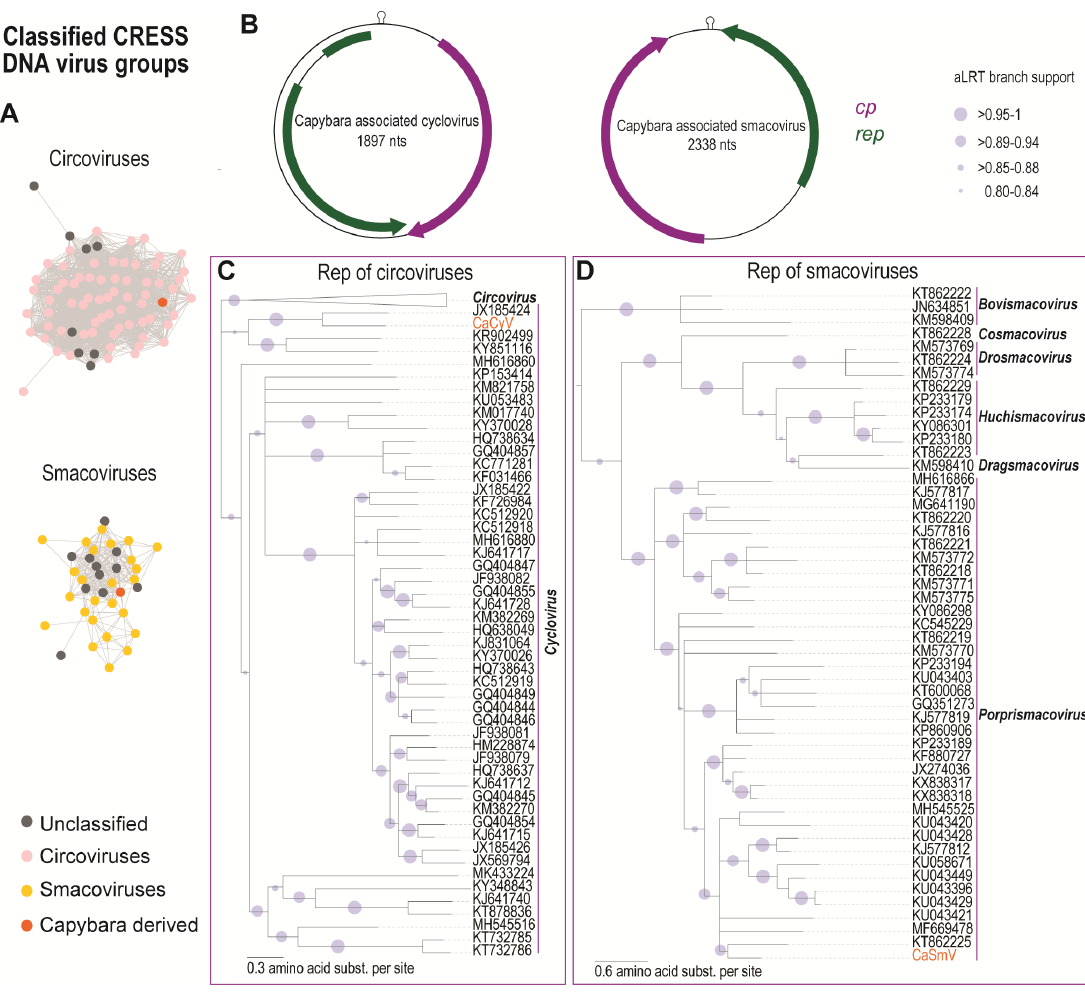
Figure 3. ( A ) Sequence similarity network analysis of the Rep amino acid sequences of viruses in the families Circoviridae and Smacoviridae . Orange dots represent the Rep of the viruses identified in this study. ( B ) Genome organisation of the capybara associated cyclovirus and capybara associated smacovirus. ( C ) Maximum Likelihood (ML) phylogenetic tree of the Rep amino acid sequences of the capybara associated cyclovirus with representative Rep sequences from viruses in the family Circoviridae . The cyclovirus Rep ML phylogenetic tree is rooted with representative sequences of unclassified CRESS DNA group (Cluster 1; Figure 4) and branches with aLRT support < 0.8 have been collapsed. ( D ) ML phylogenetic tree of the Rep amino acid sequences of the capybara associated smacovirus with representative Rep sequences from viruses in the family Smacoviridae . The ML tree has been rooted with Reps of nanoviruses, and branches with aLRT support < 0.8 were